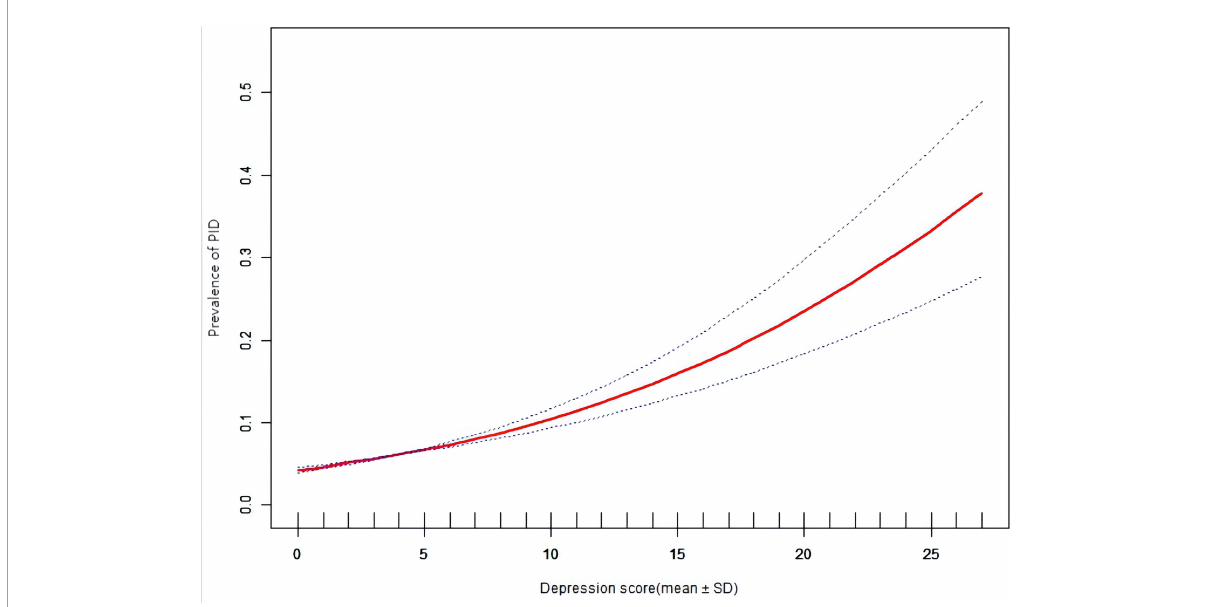
FIGURE2 Prevalence of pelvic inflammatory diseases (PID) vs. depression score: association PID and depression score: A linear association between PID and depression score was found in a generalized additive model (GAM). The solid red line represents the smooth curve fit between variables. Blue bands represent the 95% of confidence interval from the fit. All adjusted for age, education, race, BMI, Regular menstruation, WBC, Segmented